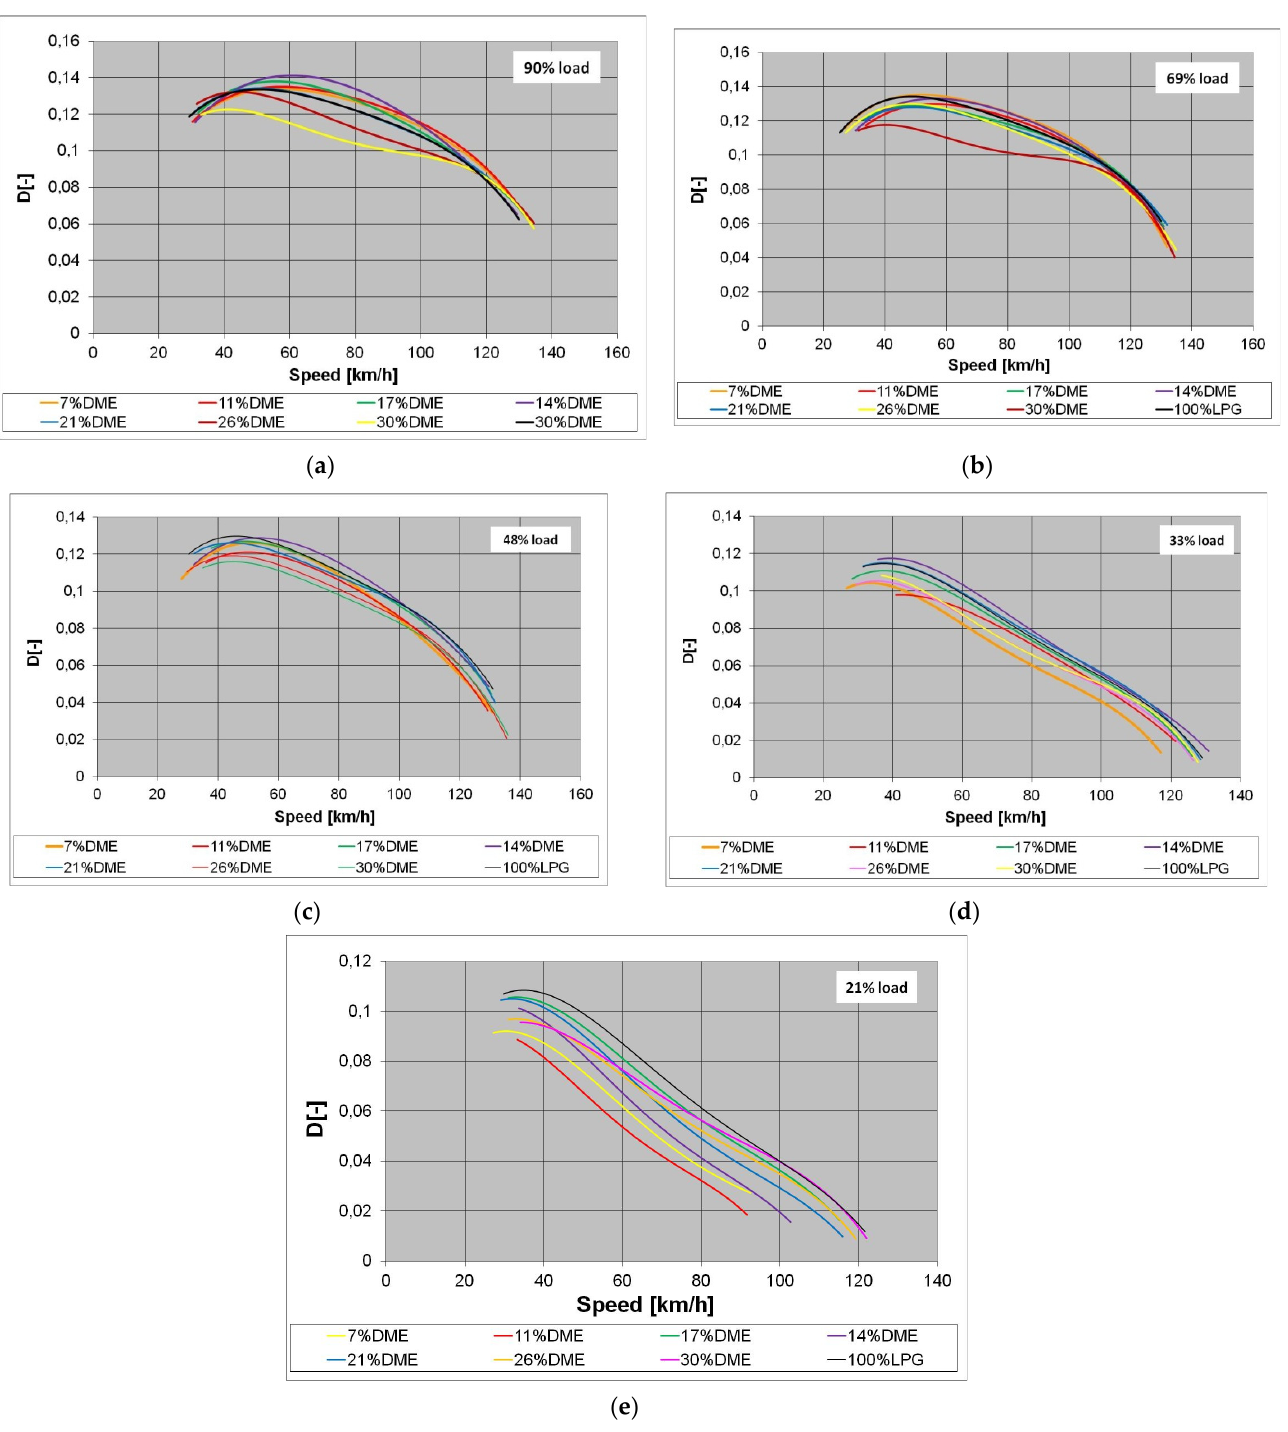
Figure 7. Values of the dynamic factor D for various shares of DME and load in the range: ( a ) 90%, ( b ) 69%, ( c ) 48%, ( d ) 33% and ( e ) 21%. Dotted lines are for data from the literature, but those data are received for maximum load (WOT). The obtained results pertain to variable loads (21–100%), which means that the results of the index for low loads are lower than the literature